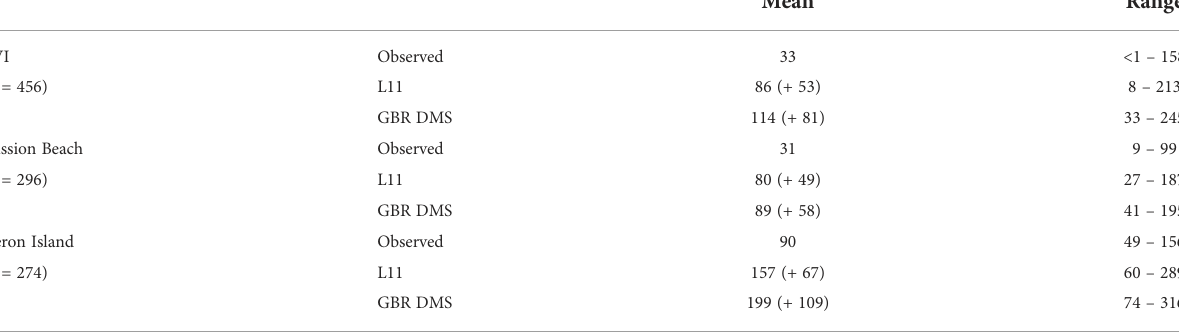
TABLE 1 Mean and range of observed and modelled DMS a (ppt or pmol mol -1 ) during the RVI, Mission Beach and Heron Island surveys of the R2R campaign [concentration (deviation from observed